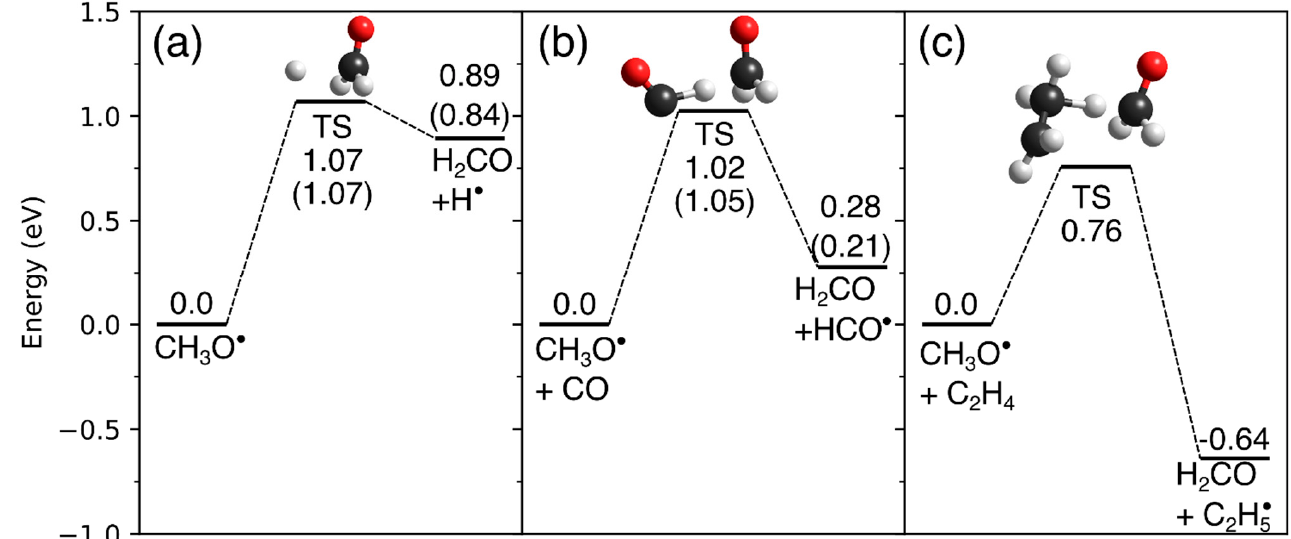
Figure 15. Zero-point energy corrected energy profiles for the ( a ) hydrogen loss from CH 3 O • yielding H 2 CO and H • , ( b ) hydrogen transfer reaction from CH 3 O • to CO yielding H 2 CO and HCO • , and ( c ) hydrogen transfer reaction from CH 3 O • to C 2 H 4 yielding H 2 CO and C 2 H 5 • . All geometries were optimized at the DFT B3LYP/aug-cc-pVTZ level of theory using RB3LYP and UB3LYP methods for closed shell and open shell species, respectively. The optimized geometries were characterized by their harmonic frequencies as minima (reactants or products) and saddle points (transition states). Improved single point energies were calculated for all minima and saddle points at the CCSD(T)/aug-cc-pVTZ level of theory. These were corrected by the zero-point vibrational energies (ZPEs) which were obtained during the DFT calculation. Calculations were performed with the ORCA 5 software package [118,119]. Previous values are given in parentheses and were reported for ( a ) by Kamarchik et al. (calculated at the RCCSD(T)/CBS level of theory) [116], and ( b ) by Wang et al. (calculated with the G2(B3LYP/MP2/CC) method)